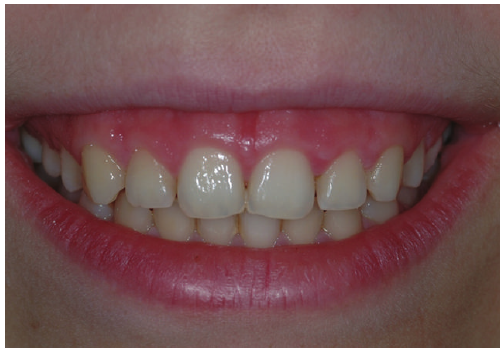
Figure 1: Pretreatment smile of patient n.5.